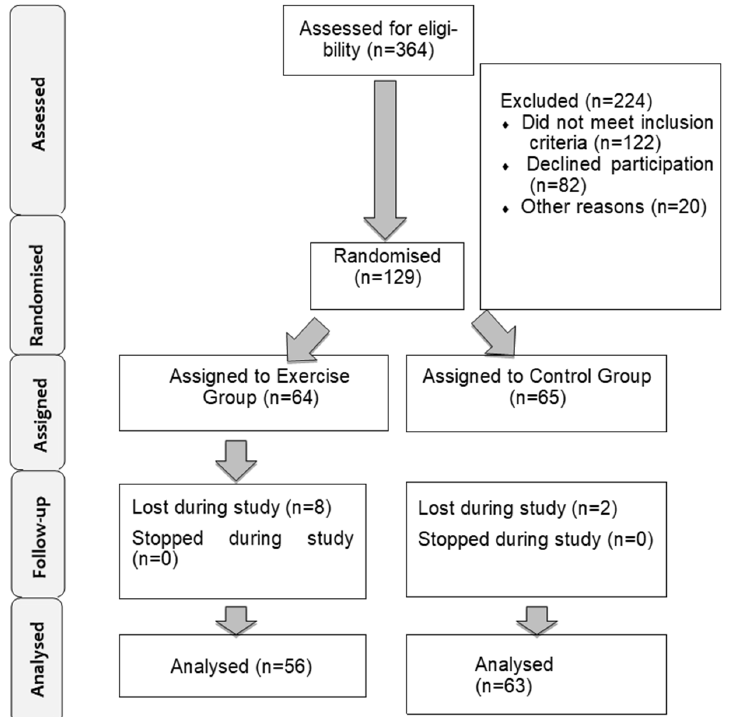
Figure 1. Description of the sample selection. Table 1. Basal characteristics of the